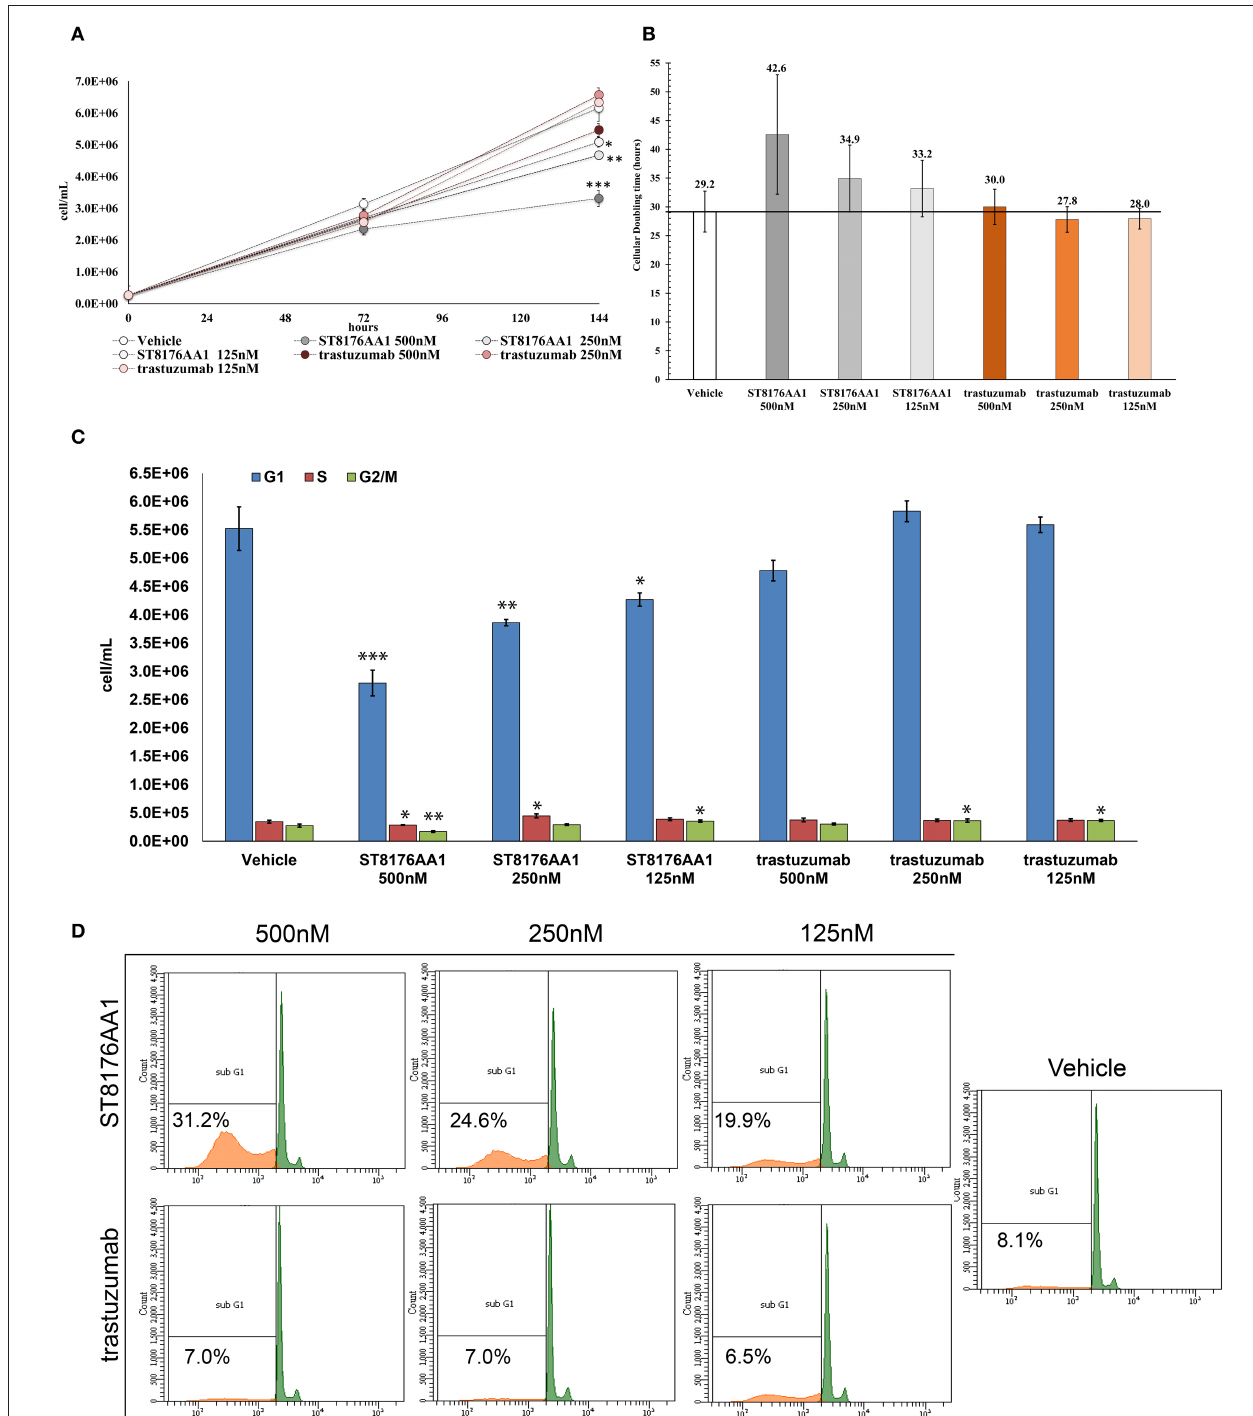
FIGURE 4 | ST8176AA1 inhibits tumor cell proliferation and induces apoptosis by perturbing the cell cycle. (A) LS174T cells were counted by nucleocounter at indicated time points after exposure to ST8176AA1 or trastuzumab (both at 500, 250, and 125nM). Data are the average ± SD ( n = 3) of counted cells. (B) Cellular doubling time (hours) calculated in the experimental conditions as in (A) . (C) Assessment of cell cycle phases after 6 days cultivation as in (A) and staining with PI. Bar graph of the average ± SD ( n = 3) of the number of cells/ml in G0/G1 (blue), S (red), and G2/M (green) phases gated on total events. (D) Flow cytometry of cells stained with PI after 6-day cultivation as in (A) . The Sub-G1 fraction of total cell population in orange. Representative results of one out of three independent samples. Student’s t -test: *** P ≤ 0.001; ** P ≤ 0.01, and * P ≤ 0.05 vs. vehicle.